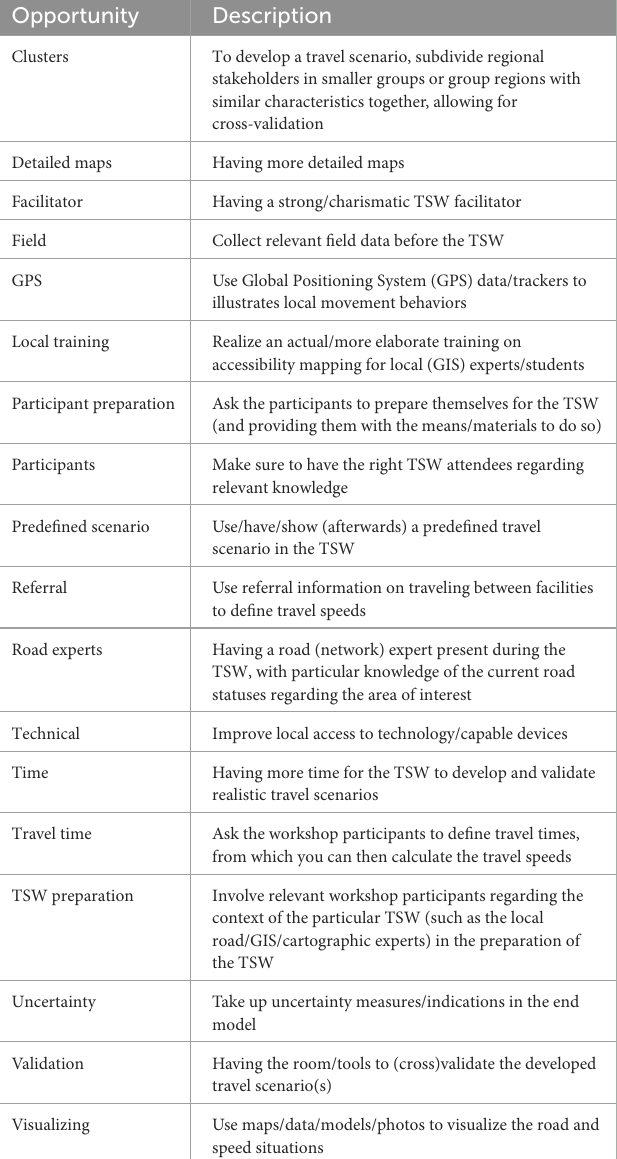
TABLE 3 Identified